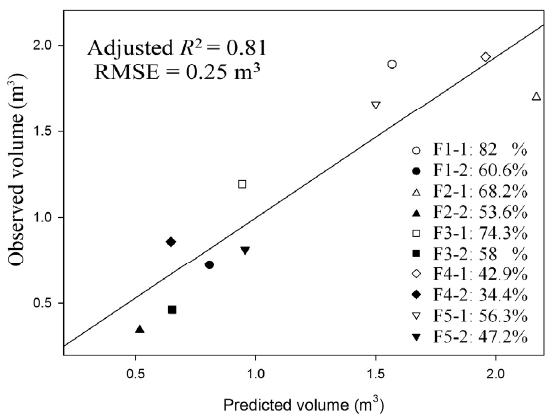
Figure 5. The Terrestrial Laser Scanning ‐ measured (observed) versus predicted understorey volume by Airborne Laser Scanning ‐ weighted percentile distribution values (calibrated using leave ‐ one ‐ out cross ‐ validation).